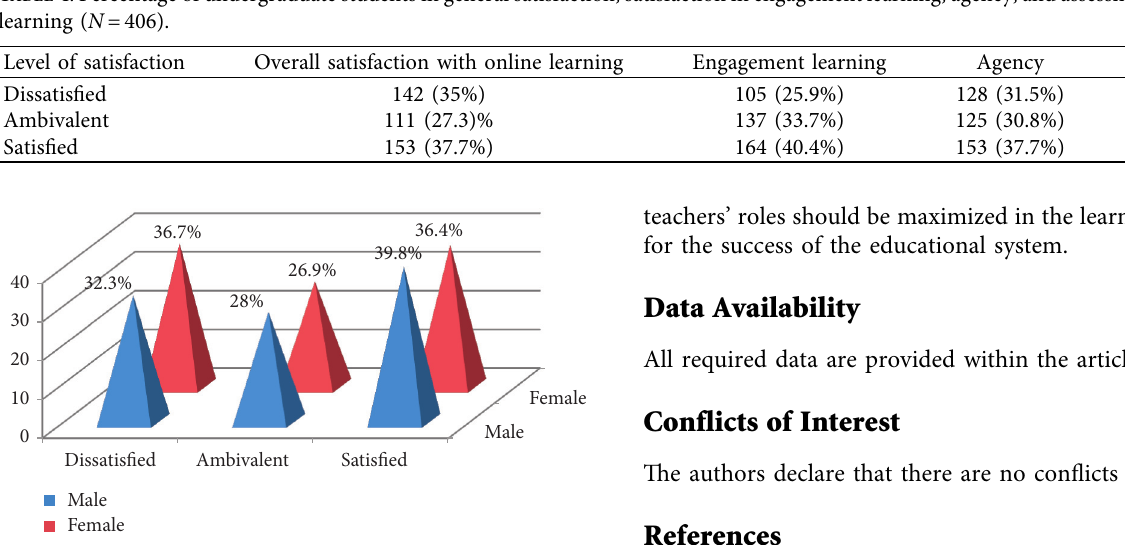
Figure 3: Percentage of general satisfaction of undergraduate students with online learning for male students ( n � 160) and fe- male students ( n �